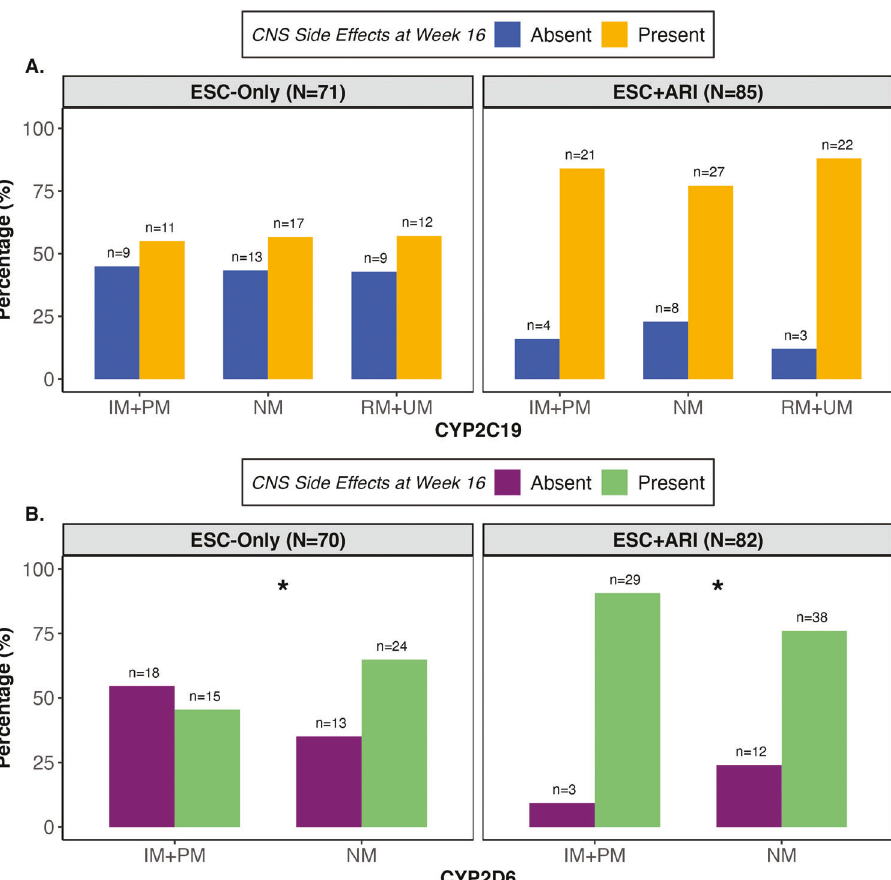
Fig. 3 Central nervous system (CNS) side effects self-reported to be present or absent by CYP2C19 and CYP2D6 metabolizer groups and treatment arm. A Central Nervous System (CNS) side effects did not show an association with CYP2C19 metabolizer group. B Presence of CNS side effects was in fl uenced by CYP2D6 metabolizer group. In ESC-Only, the odds of reporting a CNS side effect was 7.69 (SE = 6.09, 95% CI 1.63, 36.30) times higher for NMs compared to IM + PMs ( χ 2 (1, N = 70) = 6.65, p = 0.010, q = 0.048). The ESC + ARI treatment arm also showed an association between CNS side effects and CYP2D6 metabolizer group ( χ 2 (1, N = 82) = 6.70, p = 0.010, q = 0.049). The odds of reporting a CNS side effect 11.52 (SE = 10.90, 95% CI 1.80, 73.35) times higher for IM + PMs compared to NMs in this treatment arm. All logistic regression analyses were adjusted for age, ancestry, sex, recruitment site, total MADRS score at baseline, CYP2C19 and CYP2D6 metabolizer groups. P - values are corrected for multiple testing using the false discovery rate (FDR) approach. ARI aripiprazole, ESC escitalopram, IM intermediate metabolizer, NM normal metabolizer, PM poor metabolizer, RM rapid metabolizer, UM ultra-rapid metabolizer. * q < (Table S15). For CYP2C19 , IM + PMs showed lower ratios by 36.2% With NMs as the reference group, CYP2C19 IM + PMs demon- CI: [ − 0.28, − 0.11]) at Weeks 10 and 16, respectively. Interestingly, strated lower mean S-DCT adj /ESC adj ratio by 32.6% ( B = − 0.13, 95% CI: [ − 0.20, − 0.05]), whereas RM + UMs were not signi fi cantly different (Fig. 5A). Likewise, IM + PMs of CYP2D6 had S-DCT adj / ESC adj ratio that is 24.7% ( B = − 0.11, 95% CI: [ − 0.19, − 0.02]) lower than NMs (Fig. 5B). CYP2C19 and CYP2D6 PMs ( N = 5 and 2, respectively) showed the lowest DCT adj /ESC adj ratio relative to the other metabolizer phenotypes when ungrouped (Fig. S17A, B). The European subset showed the same association between DCT adj / ESC adj and CYP2C19 ( F (2,108) = 0.47, p = 0.002, q = 0.028, f 2 = 0.09) and CYP2D6 ( F (1,108) = 0.45, p < 0.001, q = 0.027, f 2 = 0.10) meta- (Fig. 5C, D). IM + PMs have S-DCT adj /ESC adj ratio that is 37.0% bolizer groups at Week 2 (Table S16). ( B = − 0.17, 95% CI: [ − 0.29, − 0.04]) and 46.9% ( B = − 0.22, 95% CI: For Phase II, in ESC-Only, S-DCT adj /ESC adj ratio showed an [ − 0.34, − 0.10]) lower than NMs at Weeks 10 and 16, respectively (Table S15). This association is observed in the European subset association with CYP2C19 and CYP2D6 metabolizer groups at only at Week 16 ( F (2,43) = 0.56 , p = 0.001, q = 0.040, f 2 = 0.25) Weeks 10 ( CYP2C19 : F (2,52) = 0.41 , p = 0.009, q = 0.048, f 2 = 0.13; CYP2D6 : F (1,52) = 0.44 , p = 0.002, q = 0.015, f 2 = 0.16) and 16 (Table S16). ( CYP2C19 : F (2,53) = 0.29 , p = 0.009, q = 0.048, f 2 = 0.16; CYP2D6 : Serum levels of ARI, DHA, and DHA/ARI ratio . A trend for an association between CYP2D6 metabolizer group and DHA at Week 10 ( F (1,61) = 13.07, p = 0.006, q = 0.046, f 2 = 0.12) and ARI adj / DHA adj ratio at Week 16 ( F (1,61) = 0.07, p = 0.010, q = 0.049,